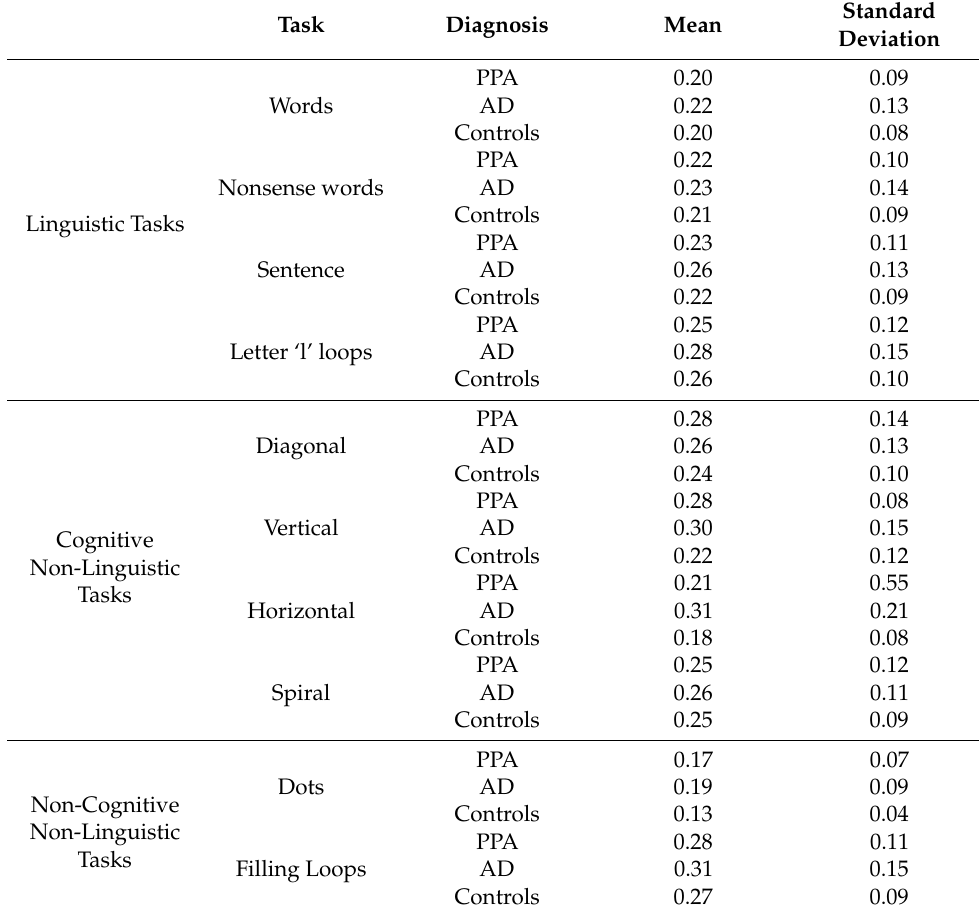
Table 2. Average writing pressure in participants with PPA, AD and Healthy Controls. Task Diagnosis Mean